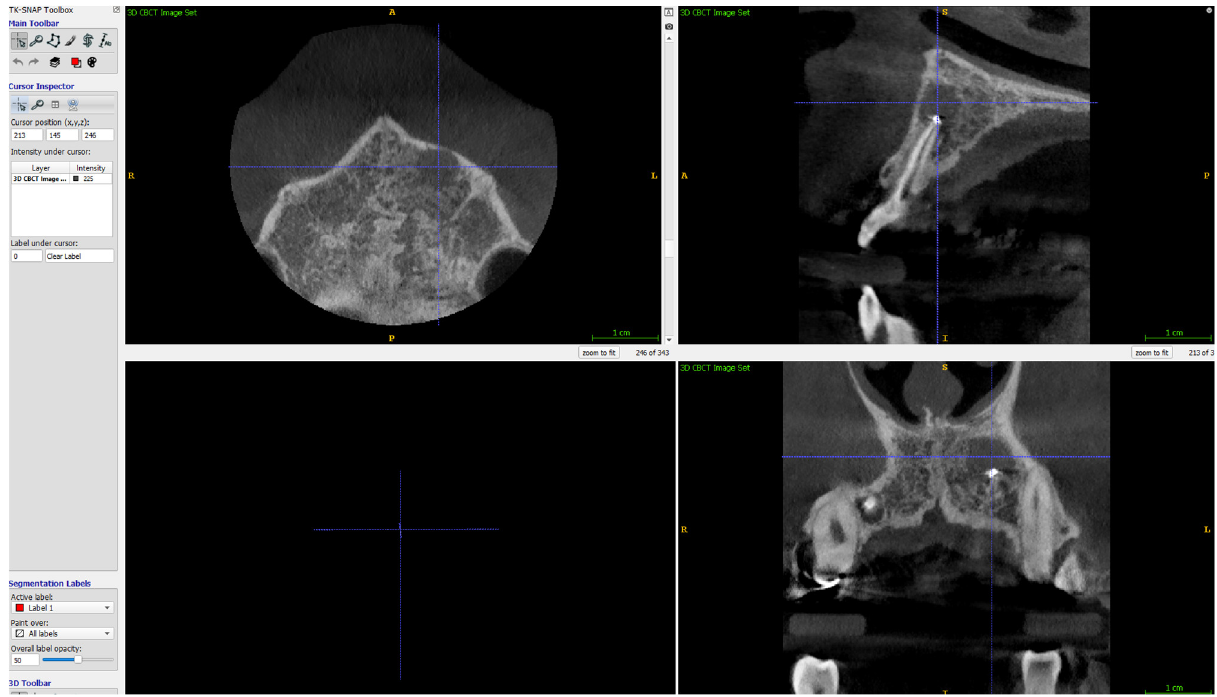
Figure 5. ITK-SNAP program surface for segmentation of 3D lesions, in saggital, axial, and coronal views. The defect is marked with the cursor, before manual limiting the field of interest.